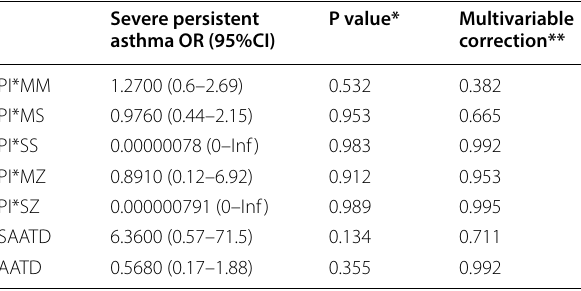
Table 4 Relationship between AATD or AAT genotypes and severe persistent